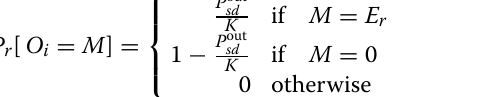
value of energy stored at R k at the beginning of i -th sig- nal block, and O i denotes the energy consumption for i -th signal block transmission. Thus, O i can be expressed as a stationary two-value random function,